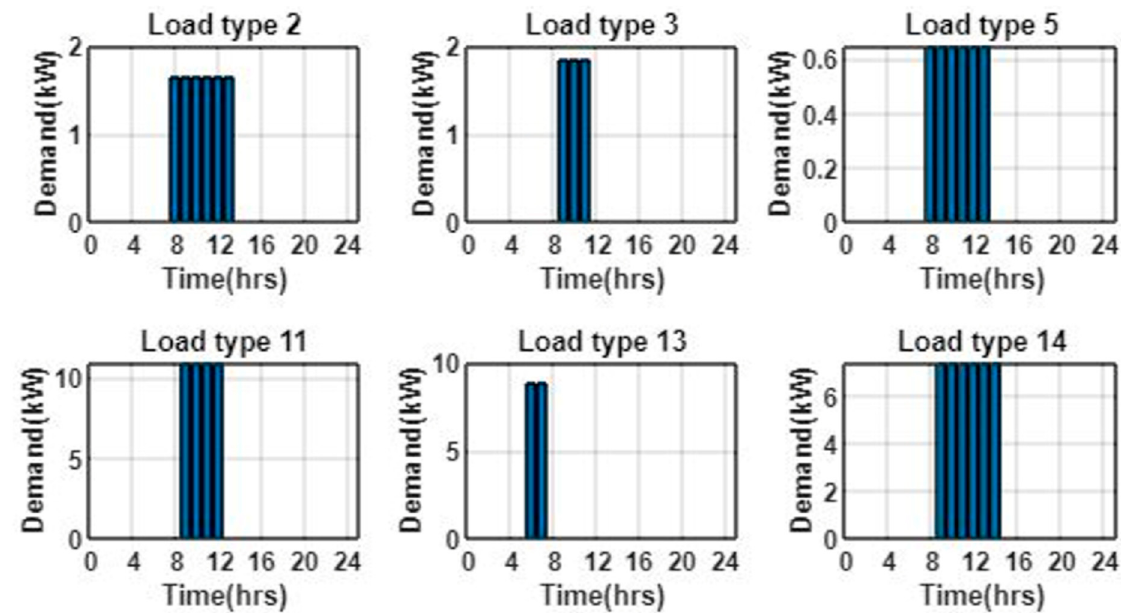
Figure 7. Unscheduled operation of user comfort load before deployment of DSM.